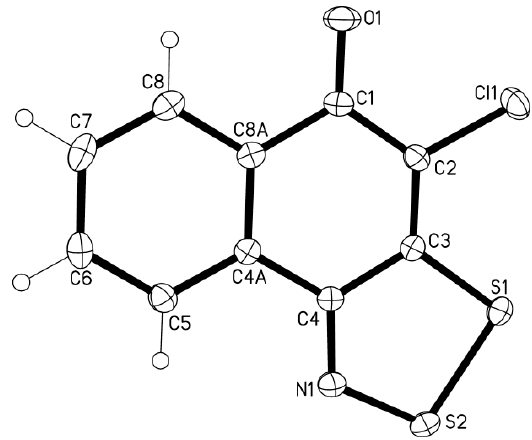
Figure 1. XRD molecular structure of dithiazole 13 (displacement ellipsoids at 50%, atoms H are shown as cycles). Selected bond distances (Å) and angles ( o ) (crystallographic numbering): C3-S1 1.7264(5), S1-S2 2.0774(5), S2-N1 1.6297(13), N1-C4 1.3054(19), C4-C3 1.456(2), C1-O1 1.2301(19), C2-Cl1 1.7259(16); C3-S1-S2 92.18(5), S1-S2-N1 98.13(5), S2-N1-C4 117.09(11), N1-C4-C3 118.65(13), C4-C3-S1 113.94(10).